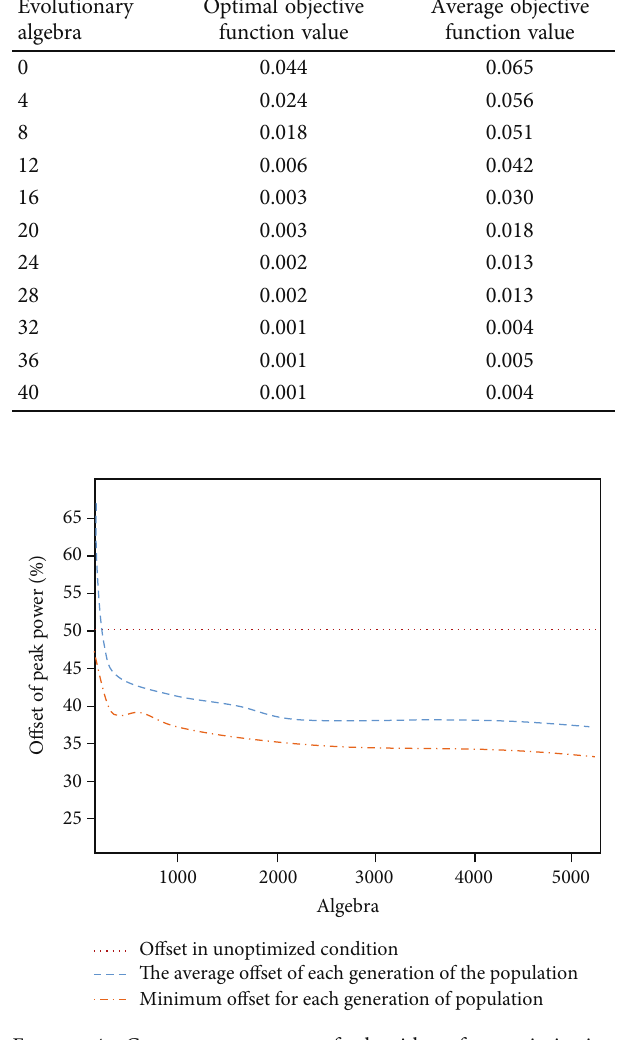
Figure 4: Convergence curve of algorithm for optimization operation.